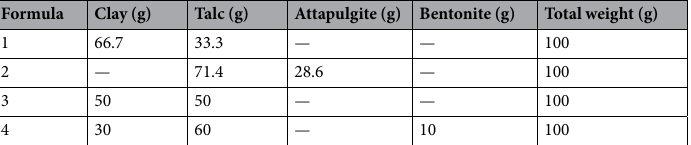
Table 1. Formulae of rice seed-pelleting agents used in the experiments. In experiment 1, Formulae 1–4 were adopted. In experiment 2, Formulae 1 and 2 were adopted. In experiment 3, Formulae 1 and 2 were adopted. In field experiment, Formulae 1 and 2 were